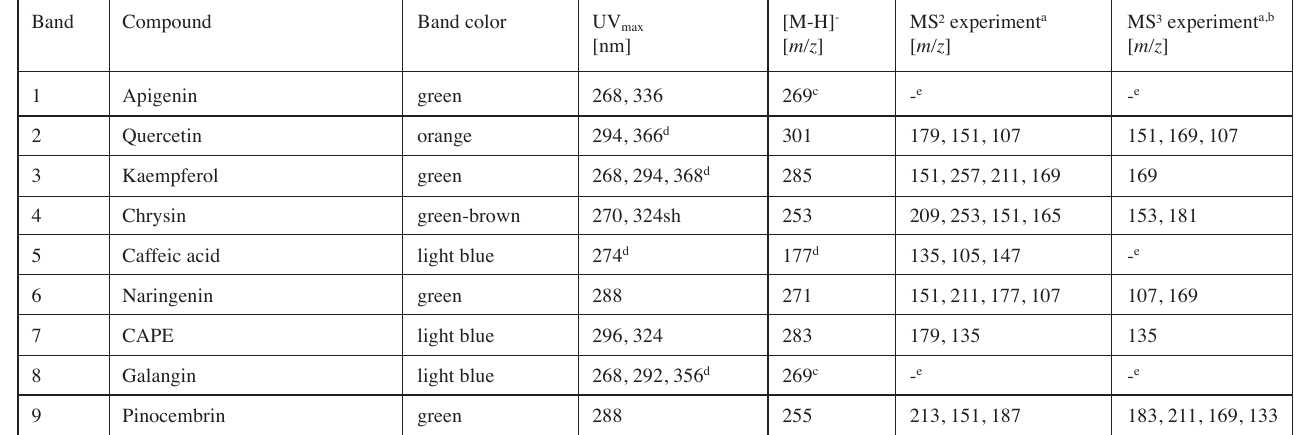
Tab. 1: TLC-MS and UV spectroscopic data obtained from the analysis of a reference mixture (see Fig. 1,